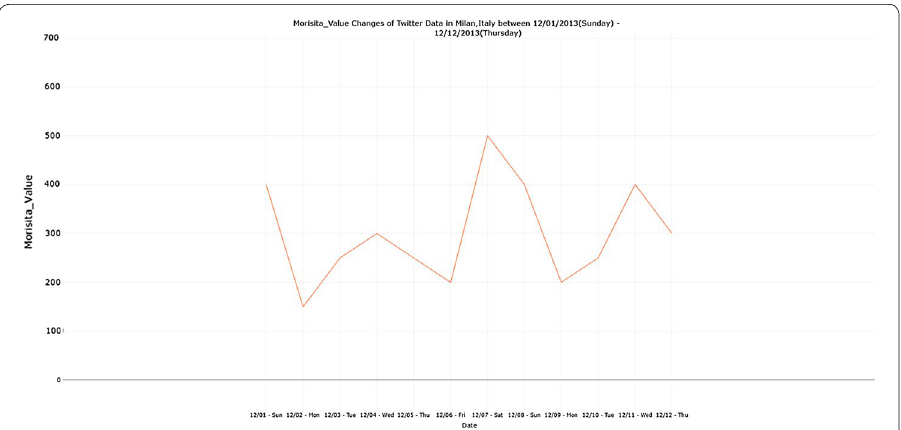
Fig. 18 Line chart of Morisita value of twitter data in Milan, Italy between 12/01/2013 and